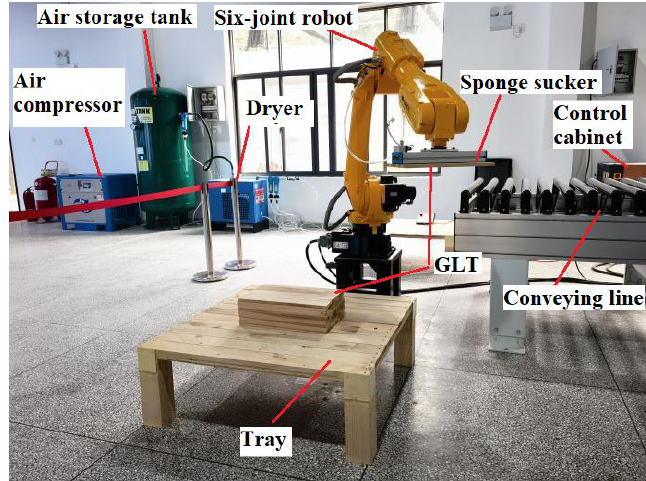
Figure 10. Robot experiment site.